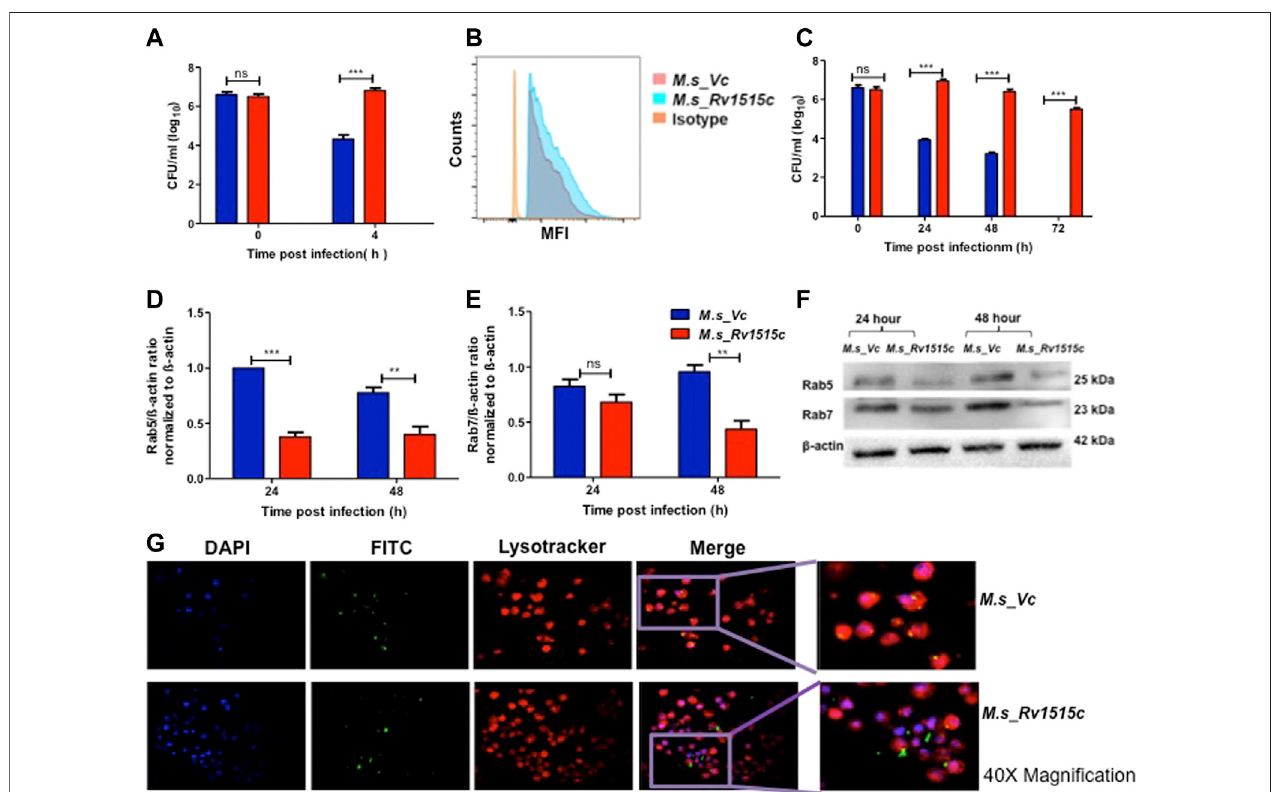
FIGURE5| Recombinant M.smegmatis expressing M.tb Rv1515cexhibitincreaseduptakeandsurvivebyescapingthephagolysosomalfusion.RAW264.7cells were incubated with equal number of M. s _Vc and M. s _Rv1515c at MOI of 1:10 for 4 h. Extracellular bacteria were washed off and RAW 264.7 cells were